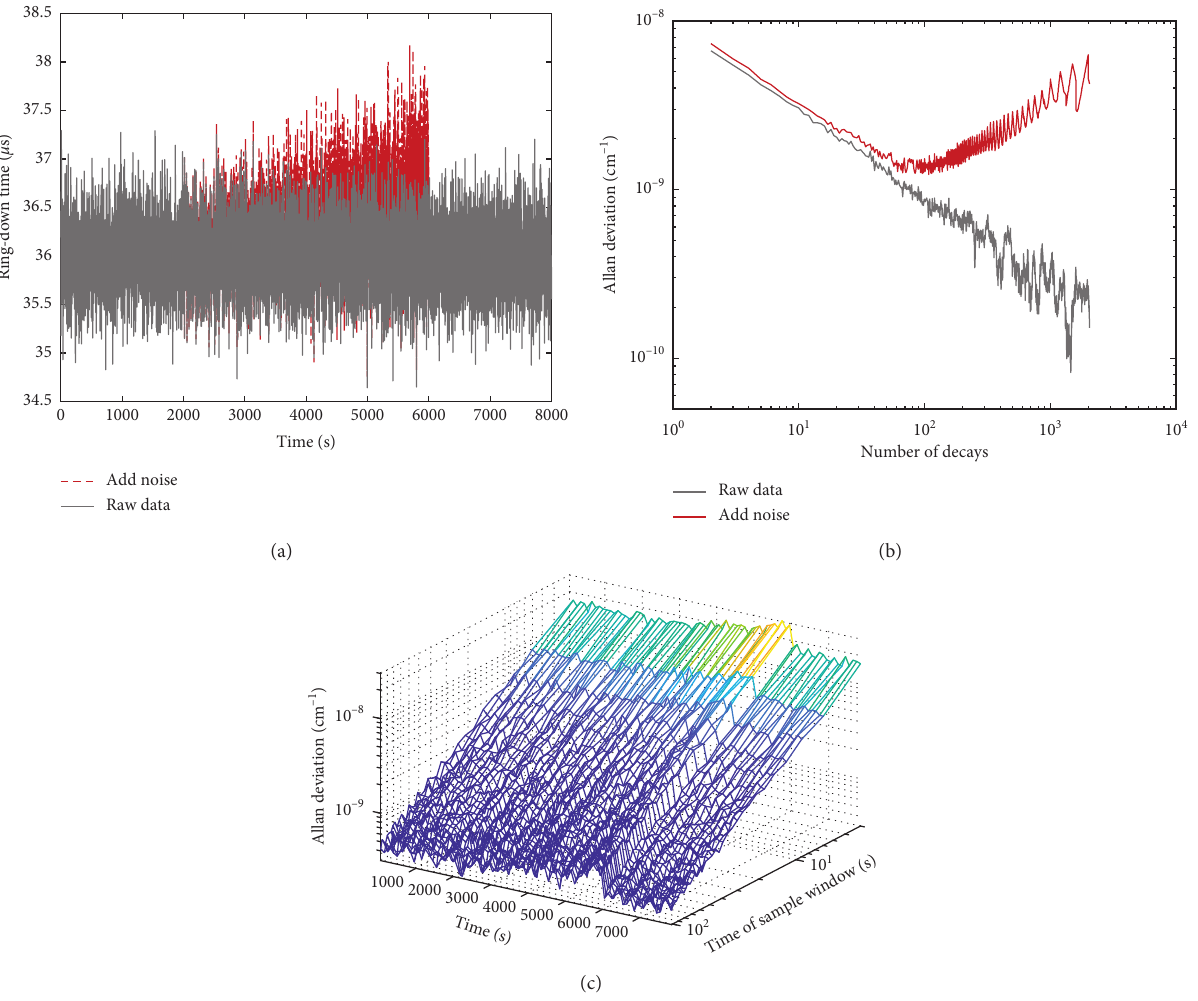
Figure 3: Allan variance and DAVAR analysis of slow-changed signals. (a) Add slow change noise to ring-down time series. (b) Using Allan variance to analyze the effect of noise on detection accuracy. (c) DAVAR analysis detection accuracy changes over